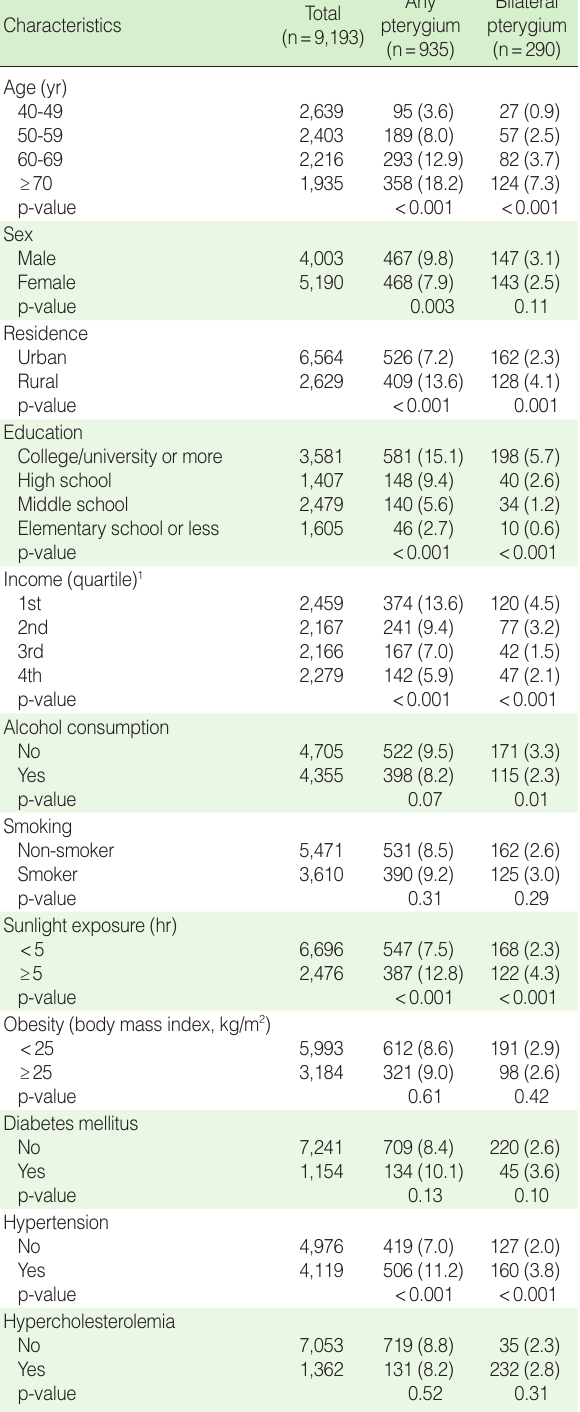
Table 1. The social and demographic features of